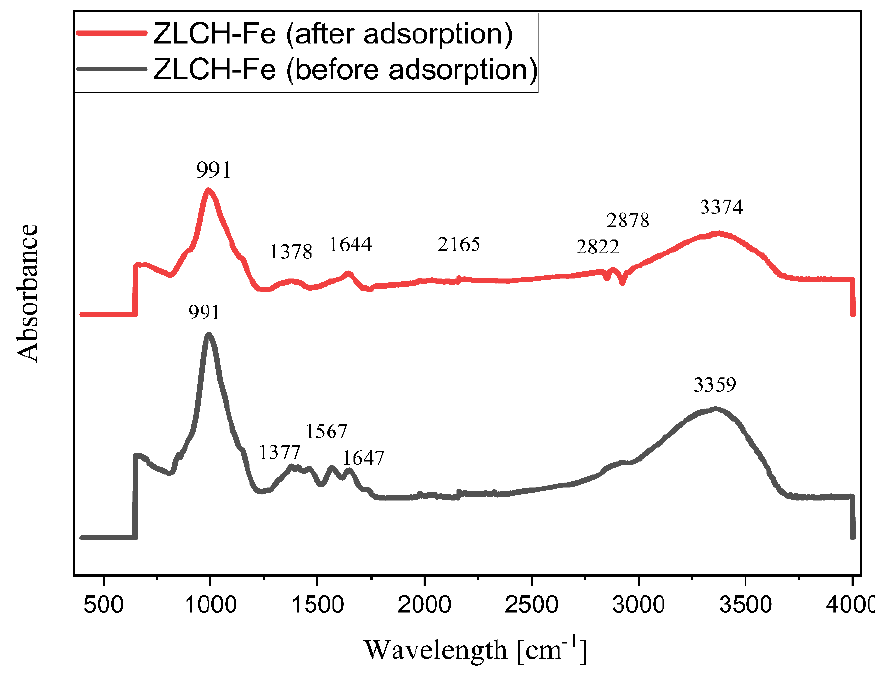
Figure 2. ATR-FTIR data before and after nitrate adsorption onto ZLCH-Fe.